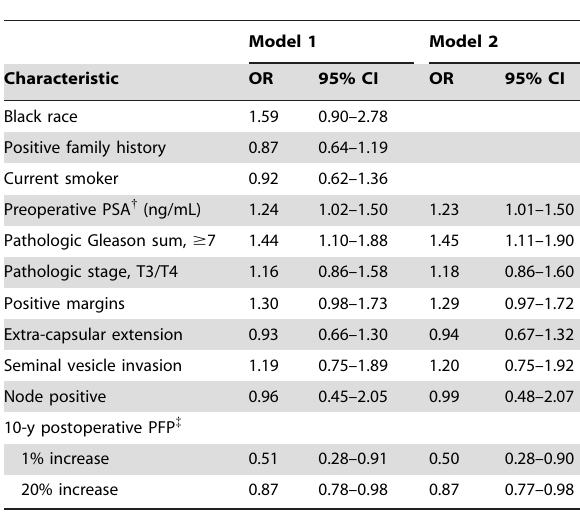
Table 3. Adjusted associations between obesity* and RP patient